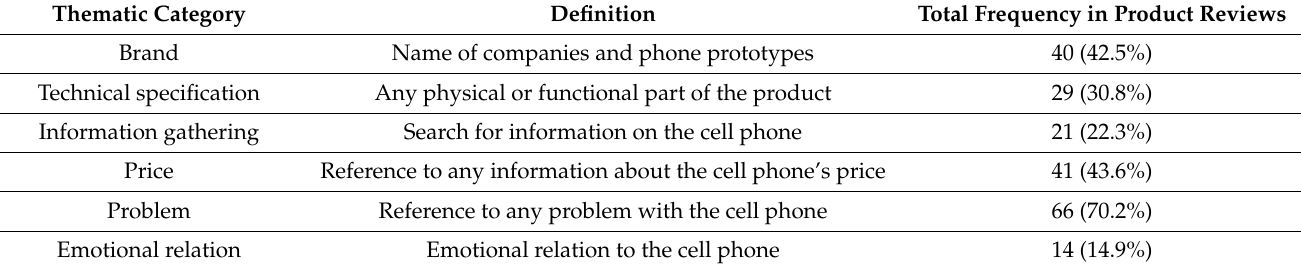
Table 2. Definitions and total frequencies of thematic